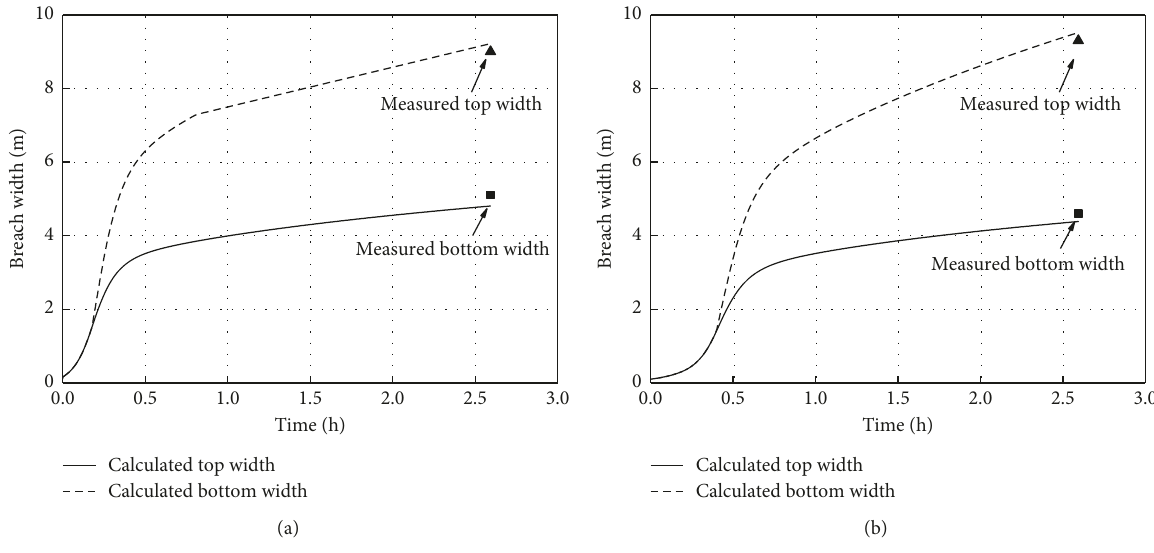
Figure 11: The evolution of the breach widths. (a) Case 1 (b) case